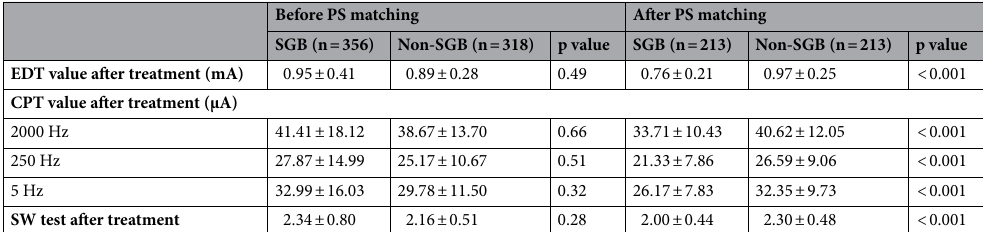
Table 2. Comparison of outcomes between the two groups at 3 months after treatment. Data are presented as mean ± standard deviation. PS propensity score, SGB stellate ganglion block, EDT electric detective threshold, CPT current perception threshold, SW Semmes–Weinstein.